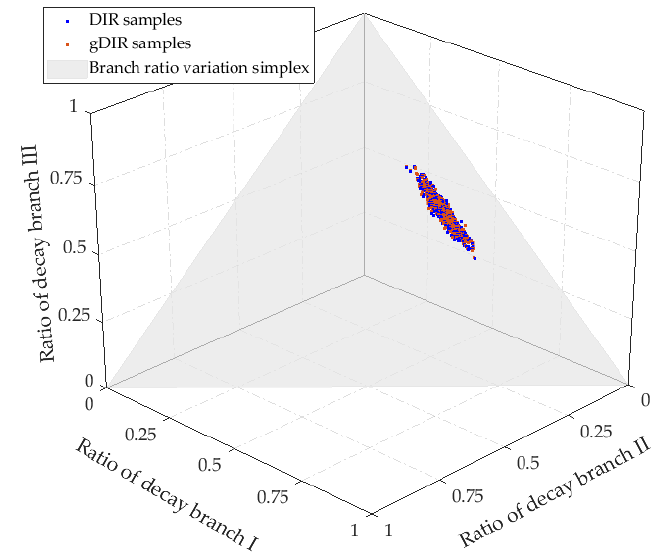
Figure 5. Scatter plot of branch ratio samples of Gallium-81 (Ga-81) (The grey shade is the possible variation surface of branch ratios due to the “sum-to-one” constraint; blue dots represent samples obtained from DIR sampling method; and red dots represent samples obtained from gDIR sampling method. Sample size in this figure is 1000 for presentation).